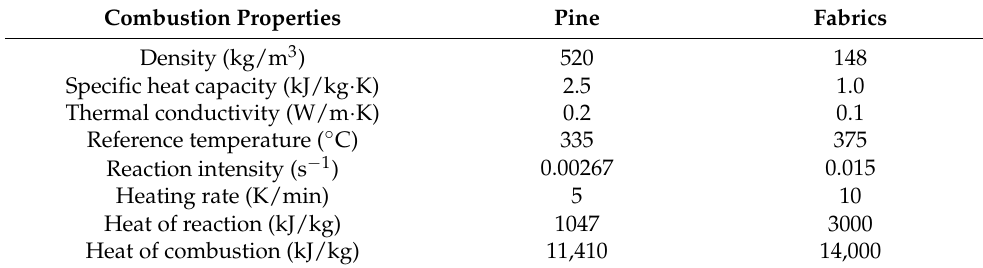
Table 2. Input data of the burning pine and the polyester/cotton blend fabrics [24,25].